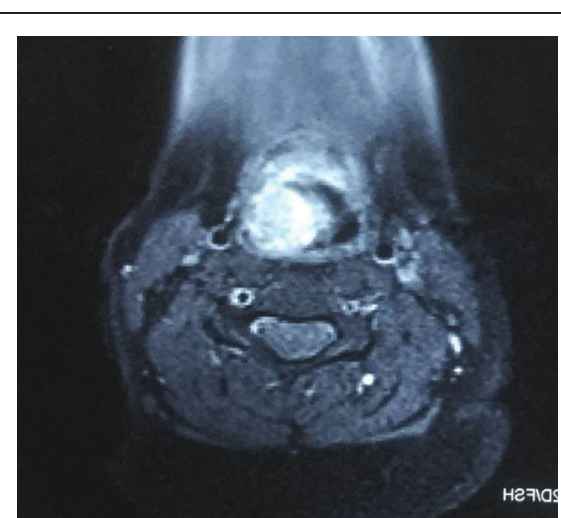
Direct laryngoscopy view of laryngeal mass.